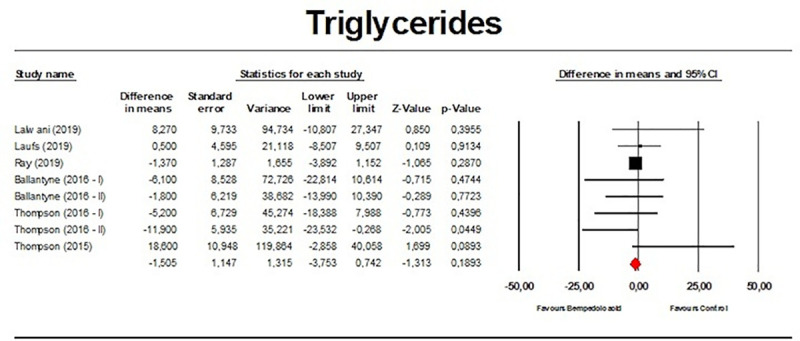
Forest plot displaying mean difference and 95% confidence intervals for the effect of bempedoic acid on plasma levels of triglycerides.